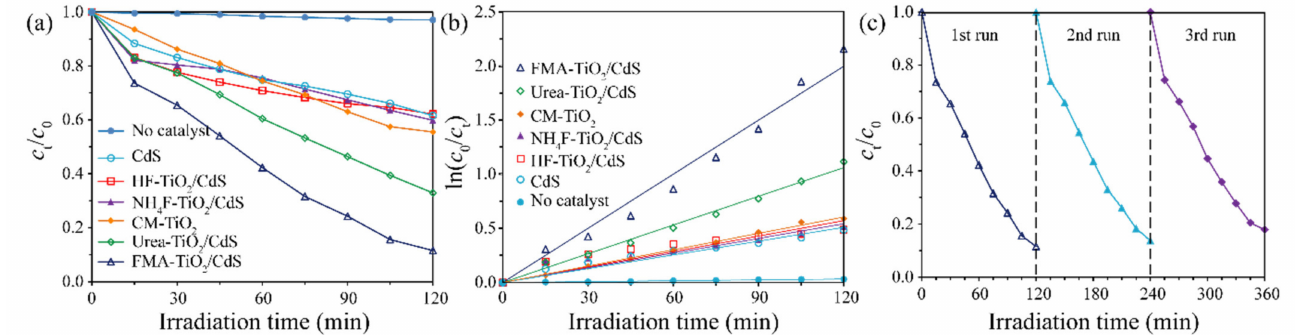
Figure 9. ( a ) Concentration change of the MO solution versus irradiation time and ( b ) the corresponding kinetic curves by No catalyst, CM-TiO 2 , CdS and different TiO 2 /CdS composites; ( c ) recyclability results of the photocatalytic degradation of MO by FMA-TiO 2